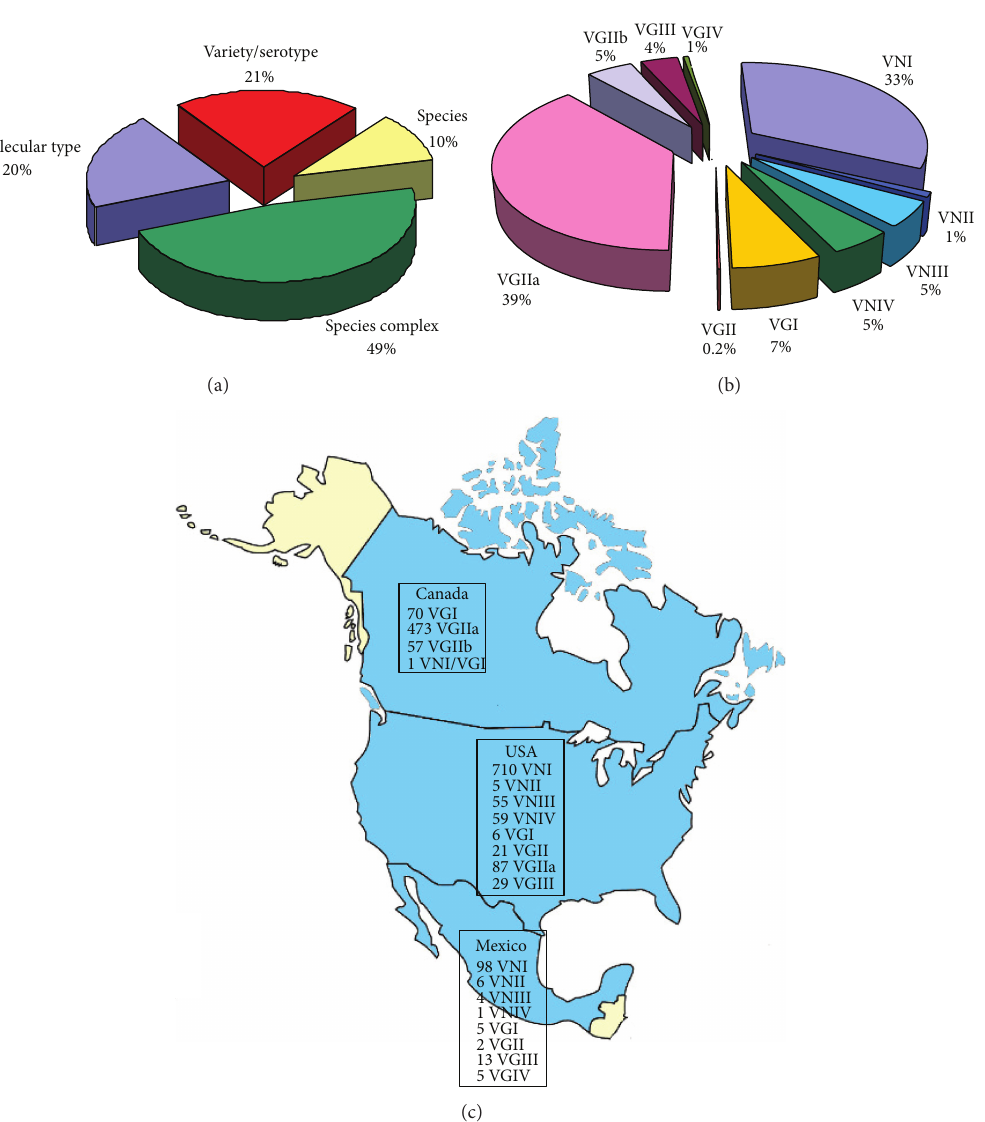
F 12: Percentage of Cryptococcus neoformans and Cryptococcus gattii isolates ( variety/serotype, or molecular type level (a). Prevalence of the different VN and VG molecular types among the isolates identi�ed at molecular type level ( ,707) (b). Geographic distribution of the molecular types identi�ed in North America (c). Molecular typing data have 𝑛𝑛 𝑛 𝑛